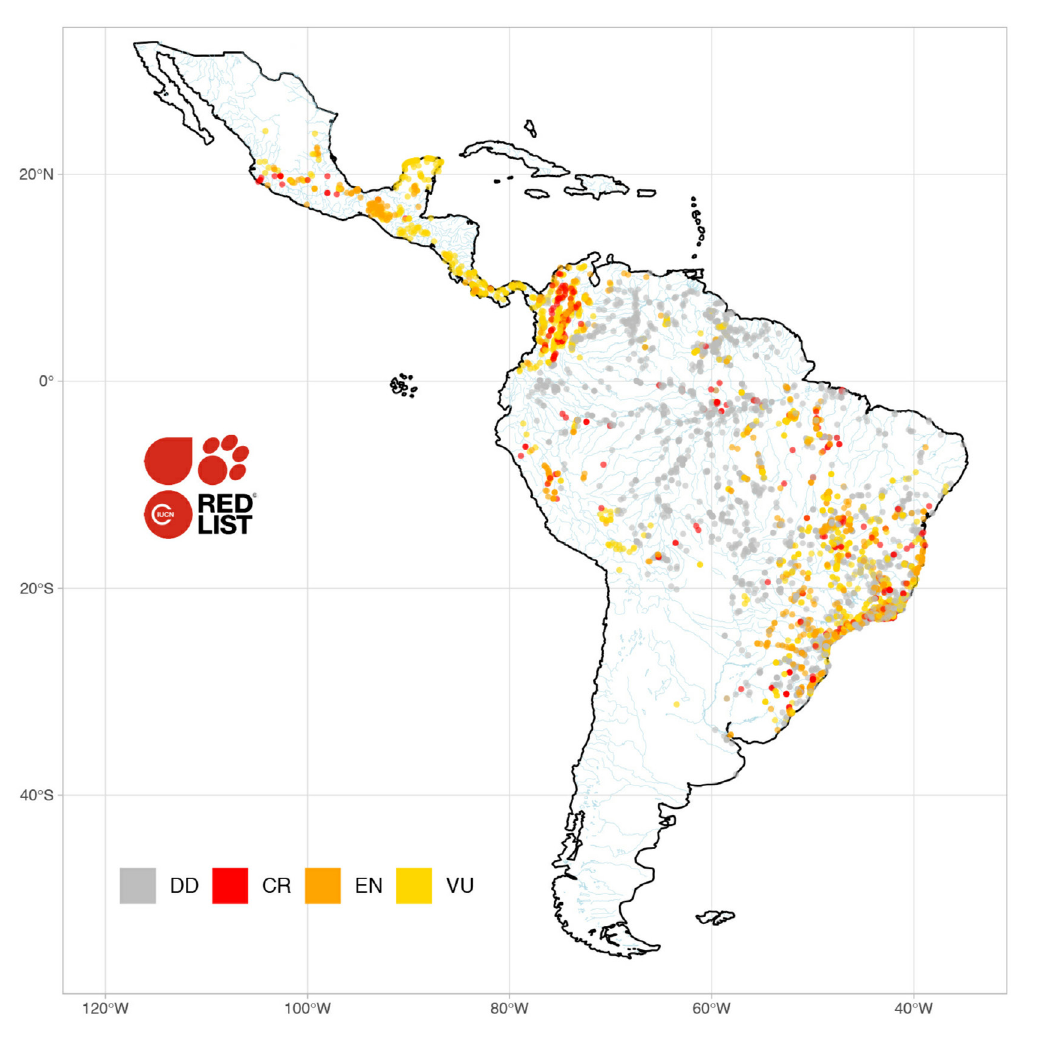
FIGURE 4 | Collection points for 442 threatened Neotropical freshwater fishes (NFF). Threatened NFF species classified by the IUCN Red List (RL) are often distributed in the upland rivers of the Brazilian Shield and the Colombian Andes, and coastal Atlantic and Caribbean drainages. CR: Critically Endangered; EN: Endangered; VU: Vulnerable; DD: Data Deficient. Data for 4,412 localities with geographic